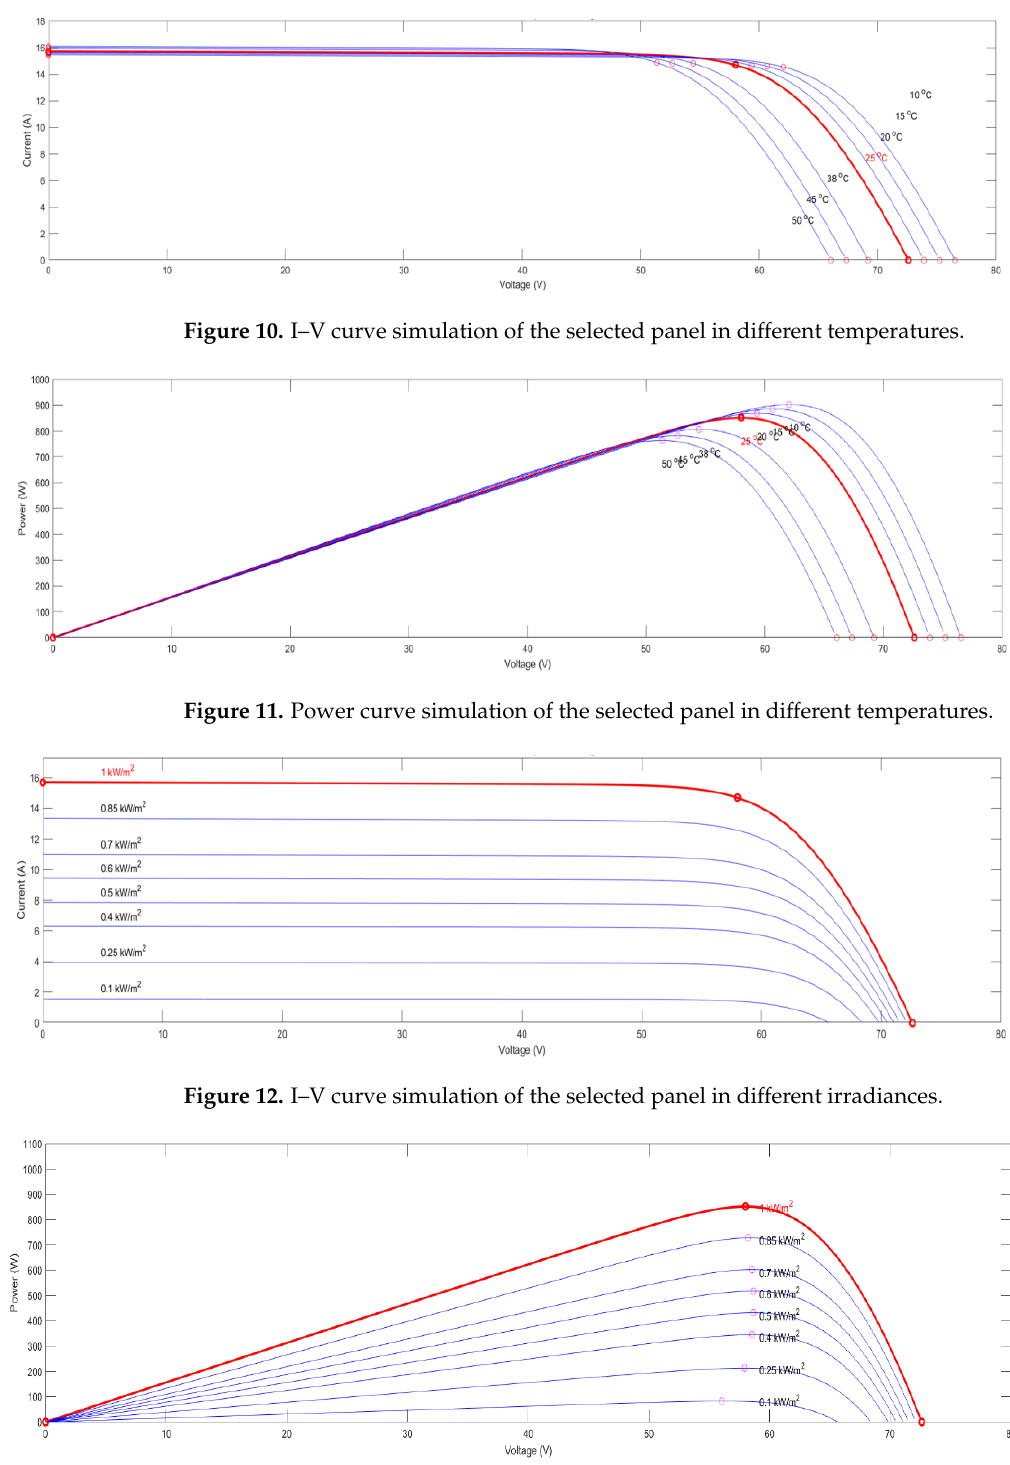
Figure 9. Photovoltaic cell equivalent circuit.